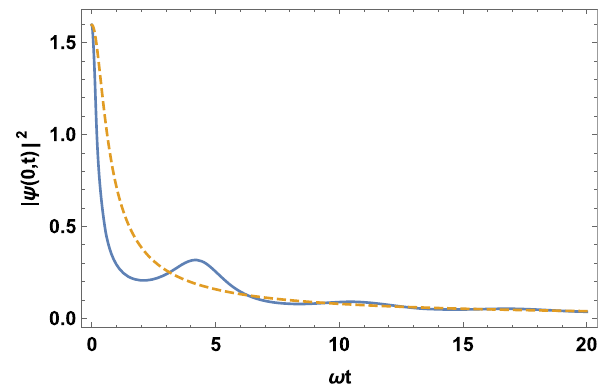
Fig. 2 The probability of detecting a particle (at x = 0) always decreases over time for a free particle in the absence of a GW (dot- ted line). In comparison, the probability of detecting the same particle can increase in the presence of the GW (solid